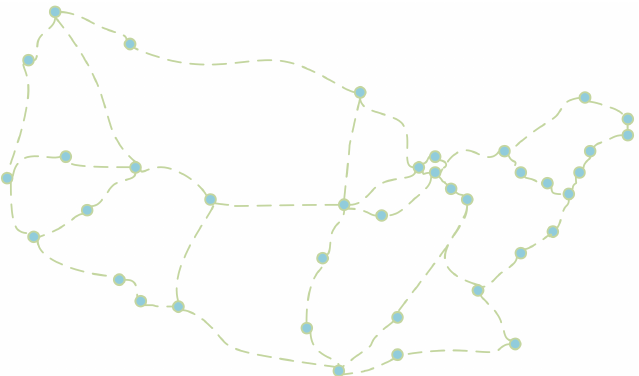
Figure 6. OS3E network